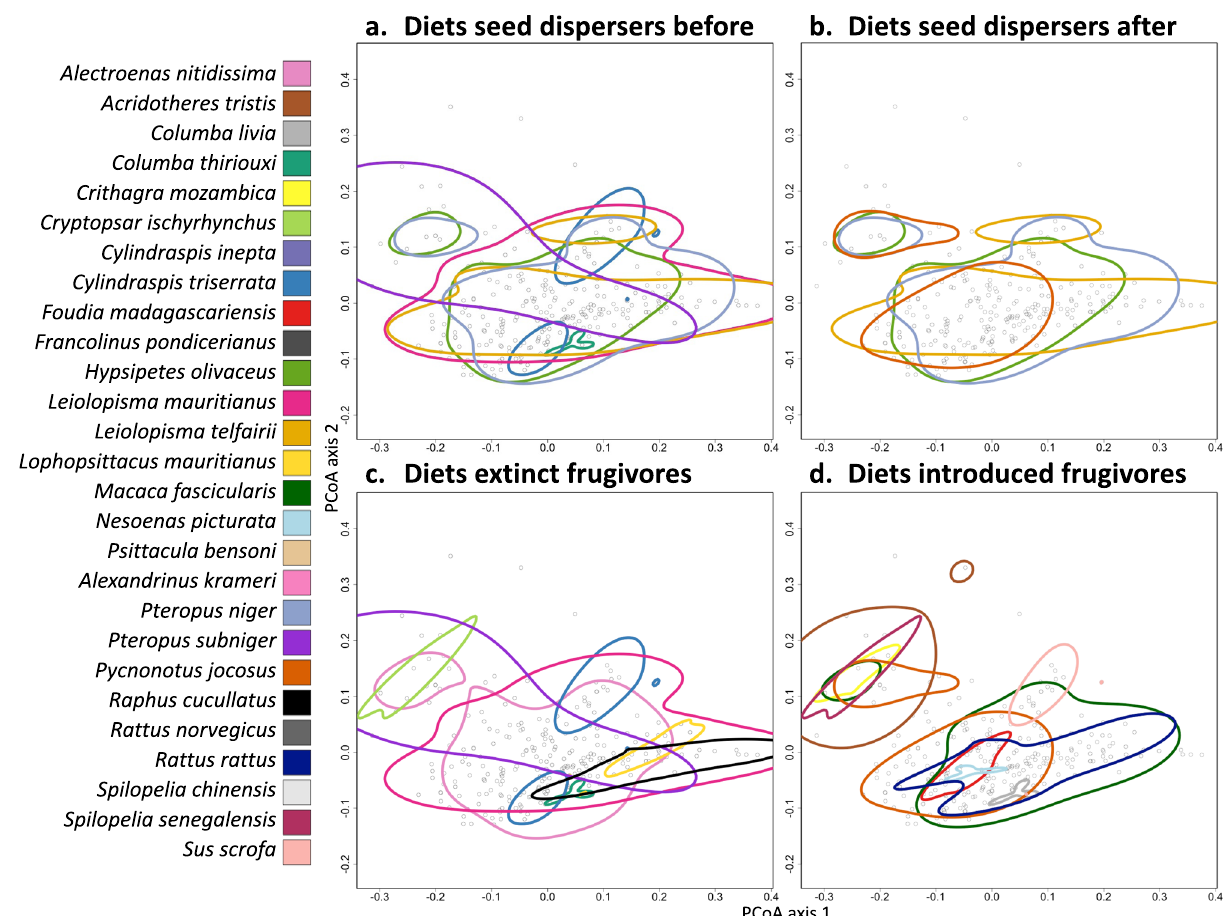
Fig. 6 | Diets of frugivores on Mauritius within the functional trait space of native plants. Known fruit-feeding interactions between frugivores and native Mauritian plants within the functional trait space of the plants ( n =263 plant spe- cies, PCoA, Gower distance, variation explained by axis 1=61.33%, axis 2=20.9%, Supplementary Fig. 2, 25% missing data imputed with 80% accuracy, Supplemen- tary Table 3). The interactions of each animal are indicated by a circle around the 95% kernel density estimate. First two panels show seed dispersal interactions